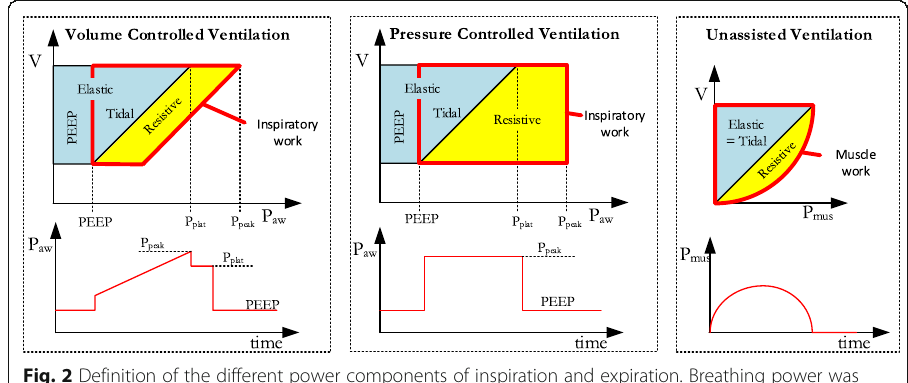
Fig. 2 Definition of the different power components of inspiration and expiration. Breathing power was introduced by Otis, resistive and elastic power was defined by Gattinoni, and Marini differentiated elastic power into its components PEEP power and tidal power. The authors now introduce the concept of inspiratory power which is composed of tidal and resistive power. Note that the figure shows work instead of power and power is the result of the product between work and ventilation